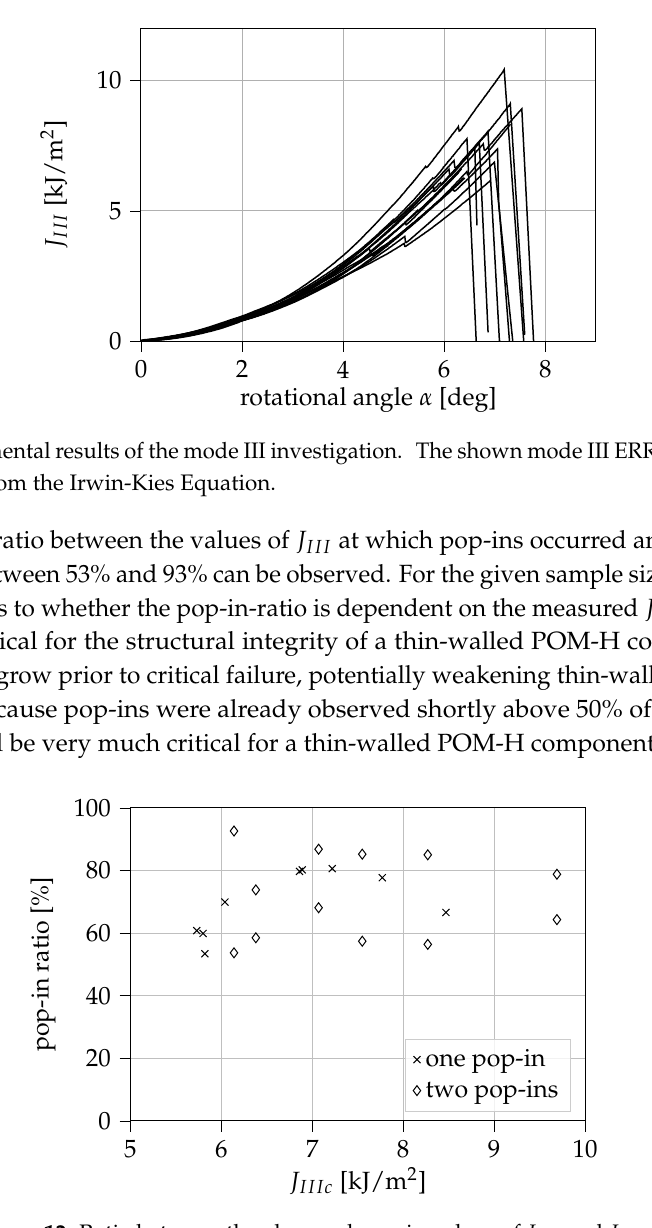
Figure 12. Ratio between the observed pop-in values of J III and J IIIc